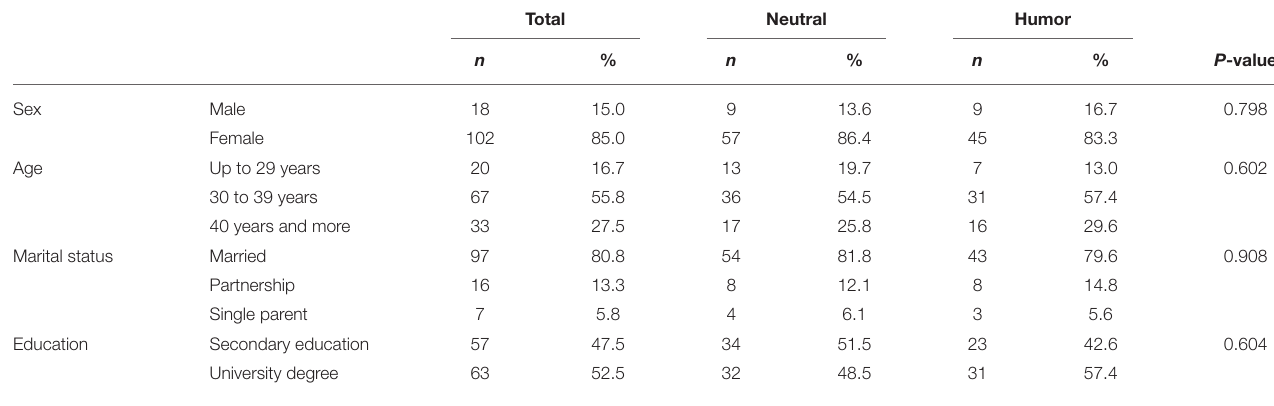
TABLE 1 | Sample characteristics ( n =